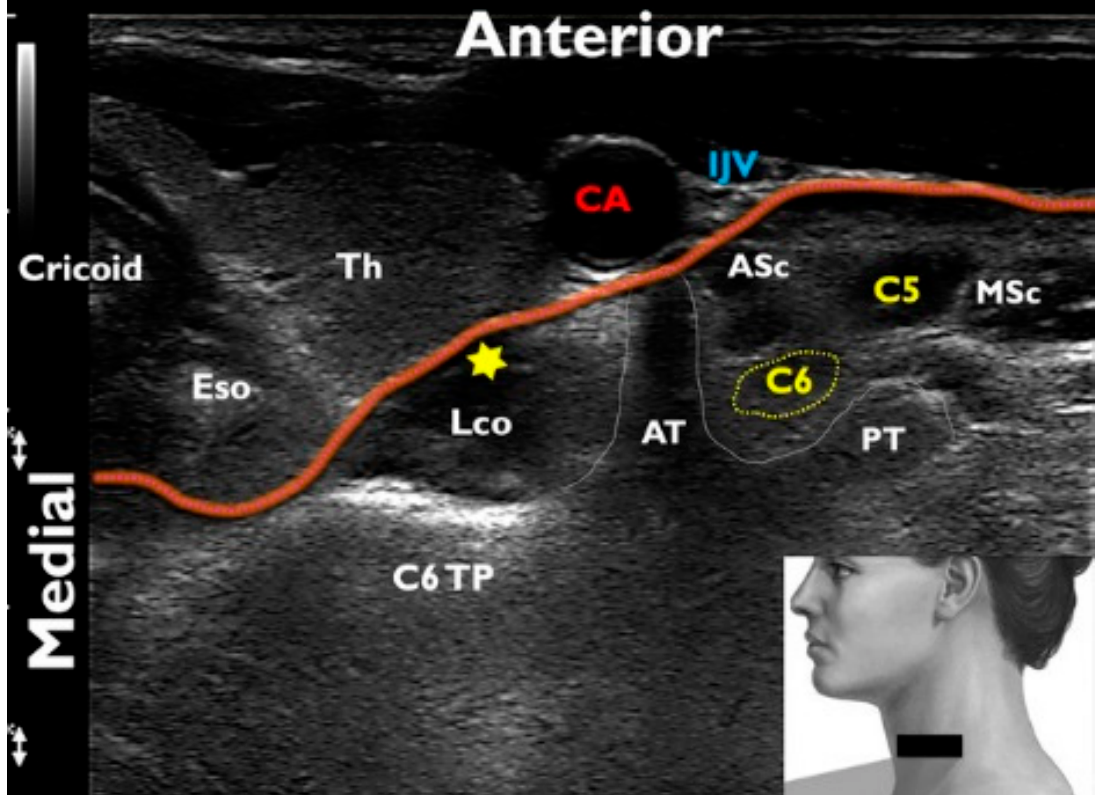
Figure 1. Transverse sonographic view of the neck at the level of C6 for a left stellate ganglion block: The probe placement on the patient’s neck is depicted in the right lower inset; the red line traces the contour of the prevertebral fascia; the yellow star represents the injection target; cricoid cartilage (Cricoid); esophagus (Eso); thyroid (Th); longus colli muscle (Lco); C6 transverse process (C6TP); anterior and posterior tubercles of the transverse process (AT and PT); carotid artery (CA); internal jugular vein (IJV); C6 and C5 nerve roots (C6 and C5); anterior and middle scalene muscles (ASc and MSc).